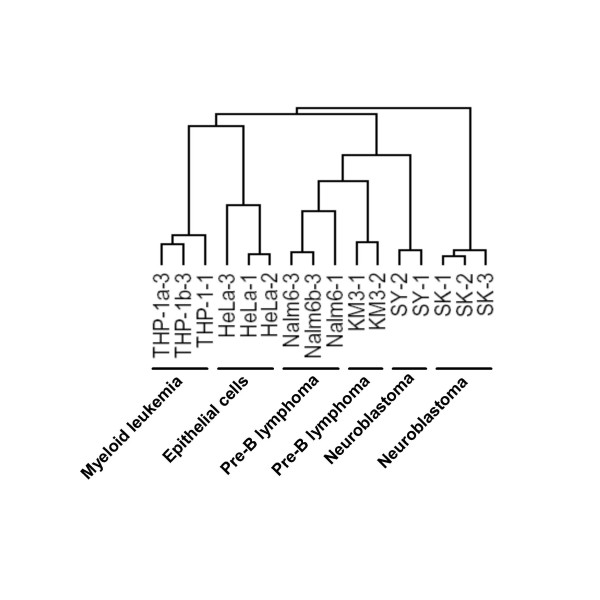
Pre-B cells and Neuroblastoma cells display similarities in overall gene expression patterns. The figure shows a hierarchical tree based on cDNA micro-array analysis of the expression of 2162 genes in a set of cell lines as indicated. Each individual hybridization experiment is represented by the name of the cell line and the number of the experiment. THP-1 is a human myeloma cell line, HeLa a human epithelial cell line, Nalm6 and KM3 represents human pre-B lymphoma. SY represents the neuroblastoma cell line SH-SY5Y and SK the neuroblastoma cell line SK-N-BE(2)c.